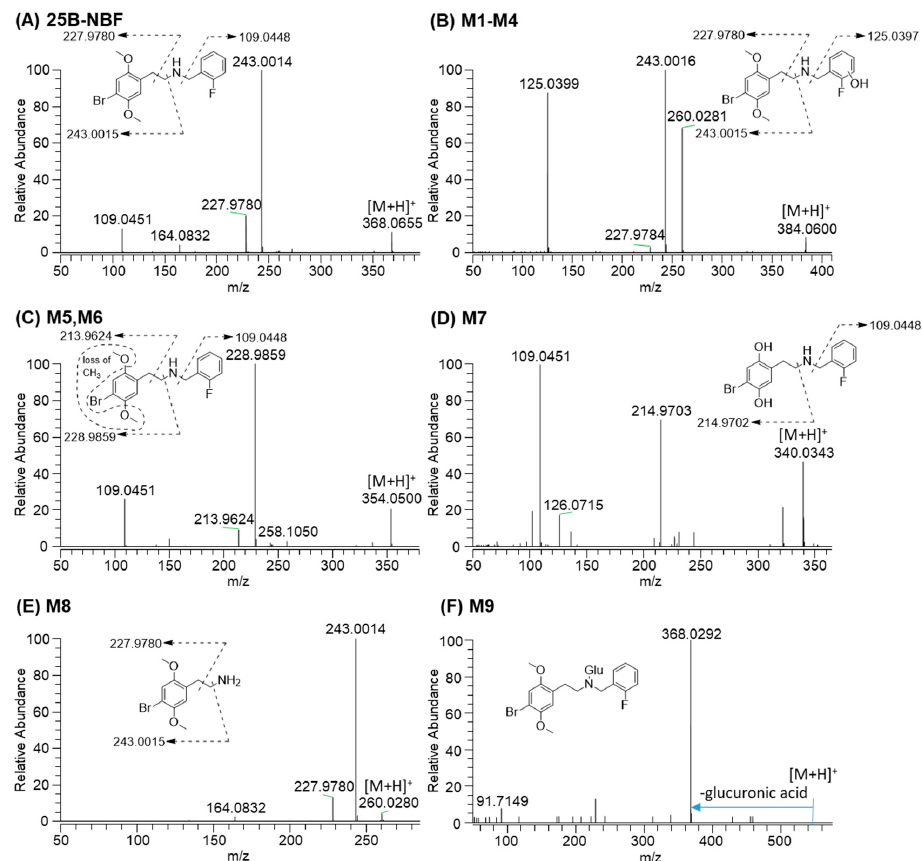
Figure 3. MS/MS spectra of 25B-NBF and typical metabolites identified after incubation with human hepatocytes for 2 h at 37 °C in a CO 2 incubator. ( A ) 25B-NBF; ( B ) hydroxyl-25B-NBF (M1–M4); ( C ) O -demethyl-25B-NBF (M5 and M6); ( D ) bis- O -demethyl-25B-NBF (M7); ( E ) 2C-B (M8); ( F ) 25B-NBF glucuronide (M9).